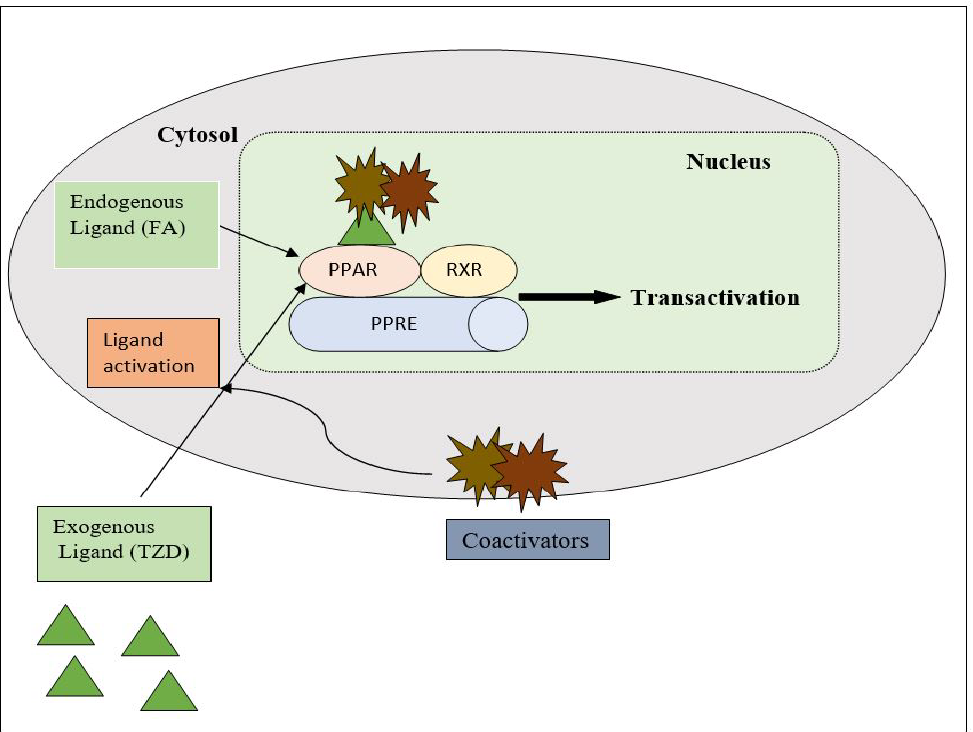
Figure 4. Gene transcription mechanisms of PPAR.